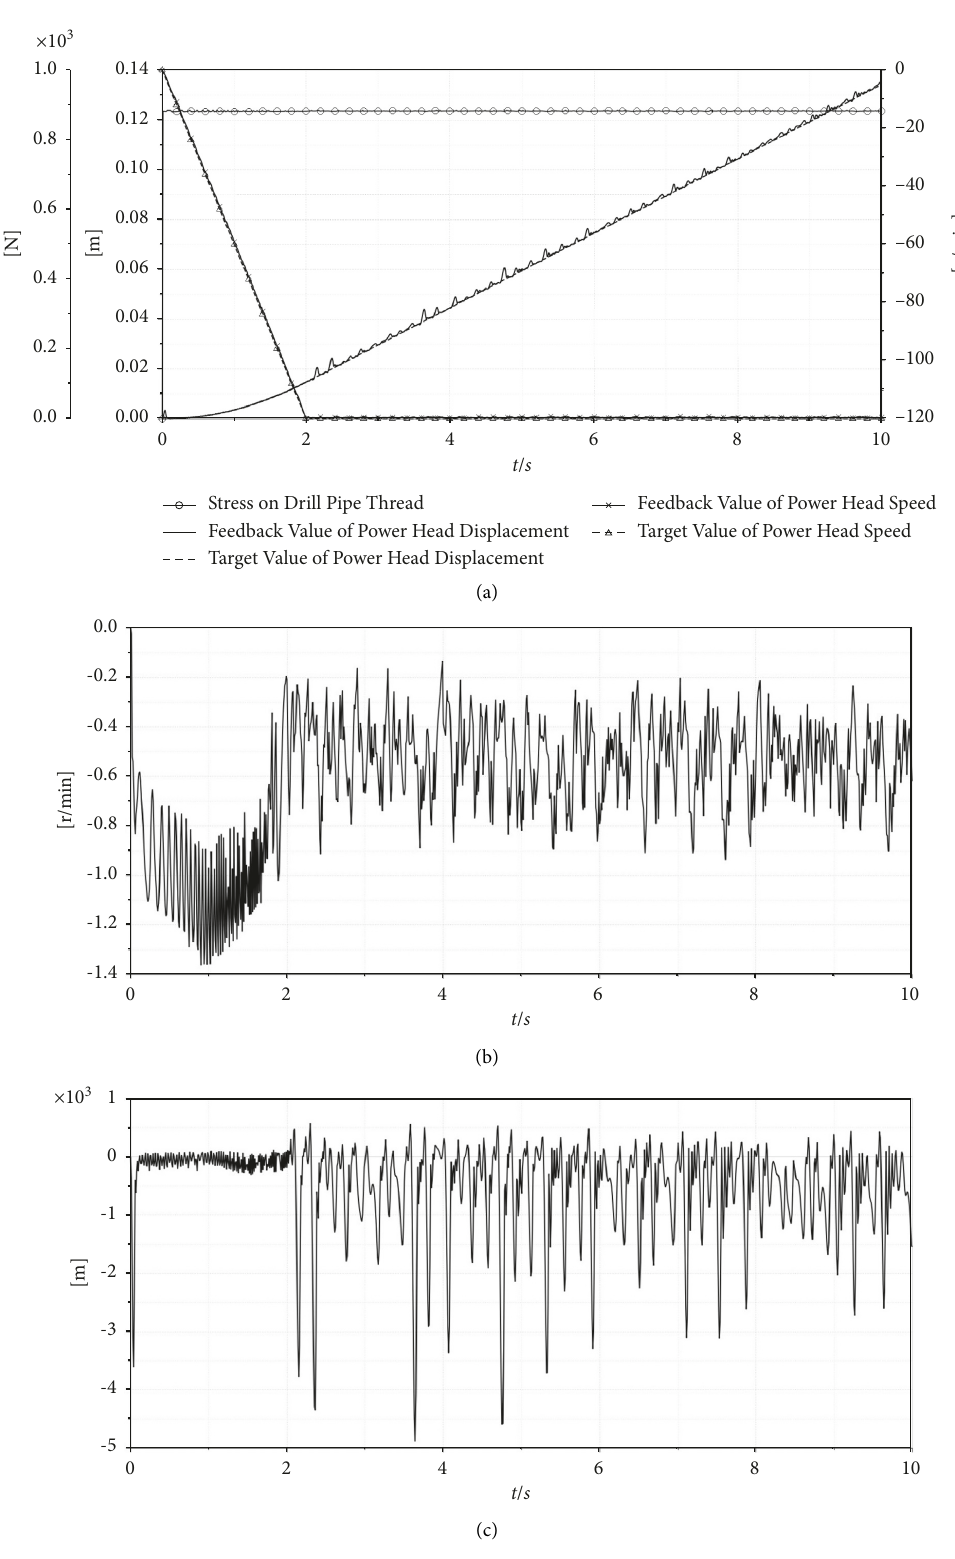
Figure 6: Simulation curve of loading and unloading drill pipe. (a) Simulation curve of loading and unloading drill pipe. (b) Error curve of powerhead speed. (c) Error curve of dynamic head